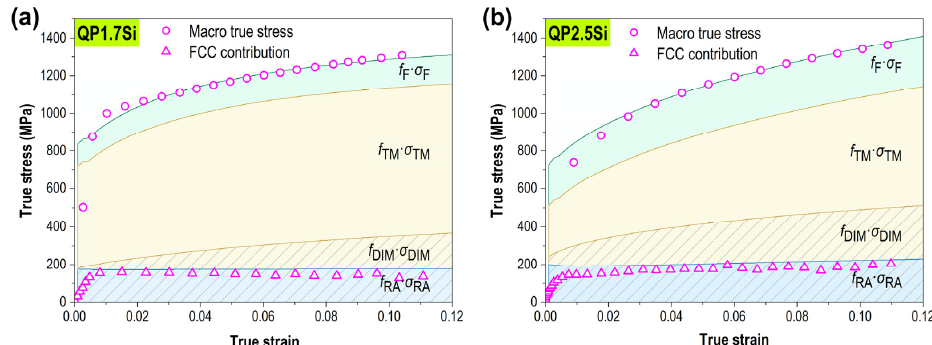
Figure 7. Stress distribution in each constituent phase obtained by neutron diffraction and model fitting. ( a ) QP1.7Si; ( b ) QP2.5Si. The FCC contribution is the product of the FCC stress and volume fraction obtained by neutron diffraction. RA, F, TM, and DIM denote the retained austenite, ferrite, tempered martensite, and deformation-induced martensite, respectively.